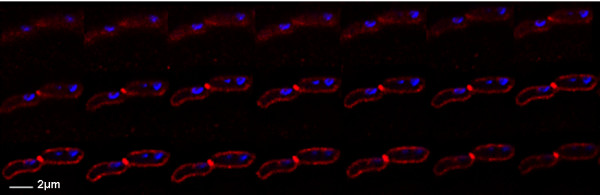
Optical sections of a pair of D. grandis cells. The series is in order from left to right of the images within a row and from top to bottom of the rows within the figure. Images are taken at 100 nm intervals.